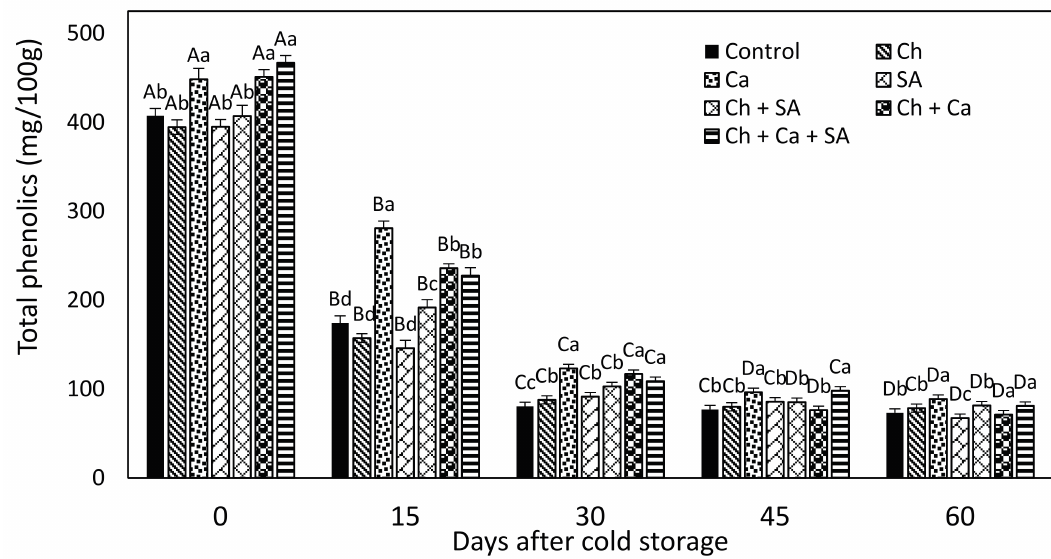
Figure 5. Effect of different preharvest treatments on total phenol content of ‘Khesab’ fruit during cold storage, values are the mean ( n = 3) ± SE. Means with different letters between treatments (small letter) at different time interval (capital letter) are significantly different at p < 0.05 using LSD test. Ch: chitosan; Ca: calcium chloride; SA: salicylic